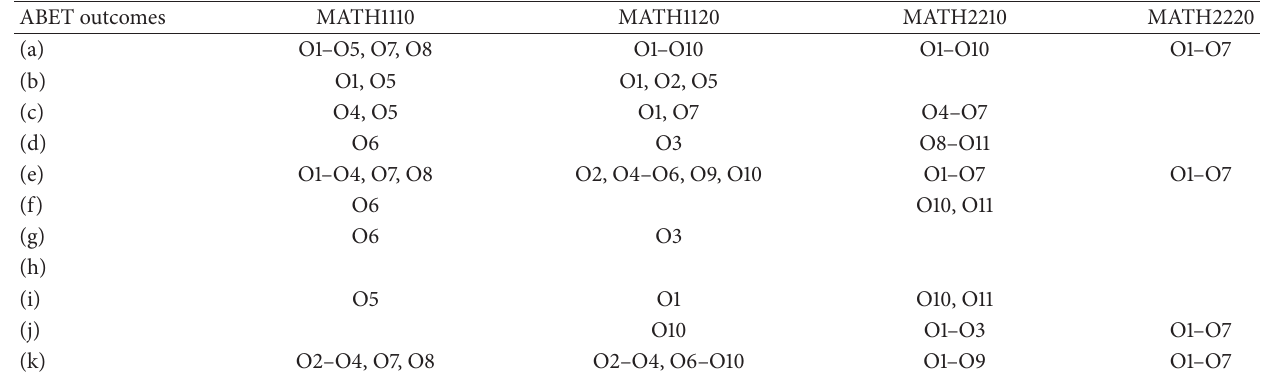
Table 5: ABET outcomes versus math courses